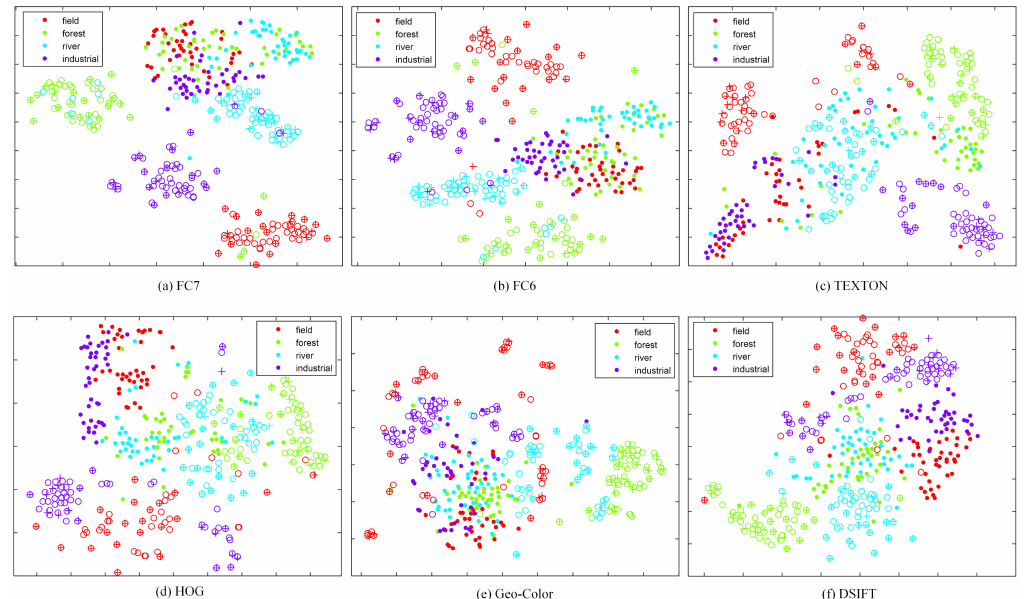
Figure 7. 2D visualization of the S1 → T3 cross-view scene dataset with different features. The solid points, hollow points, and cross points represent the source images, target unlabeled images and target labeled images,